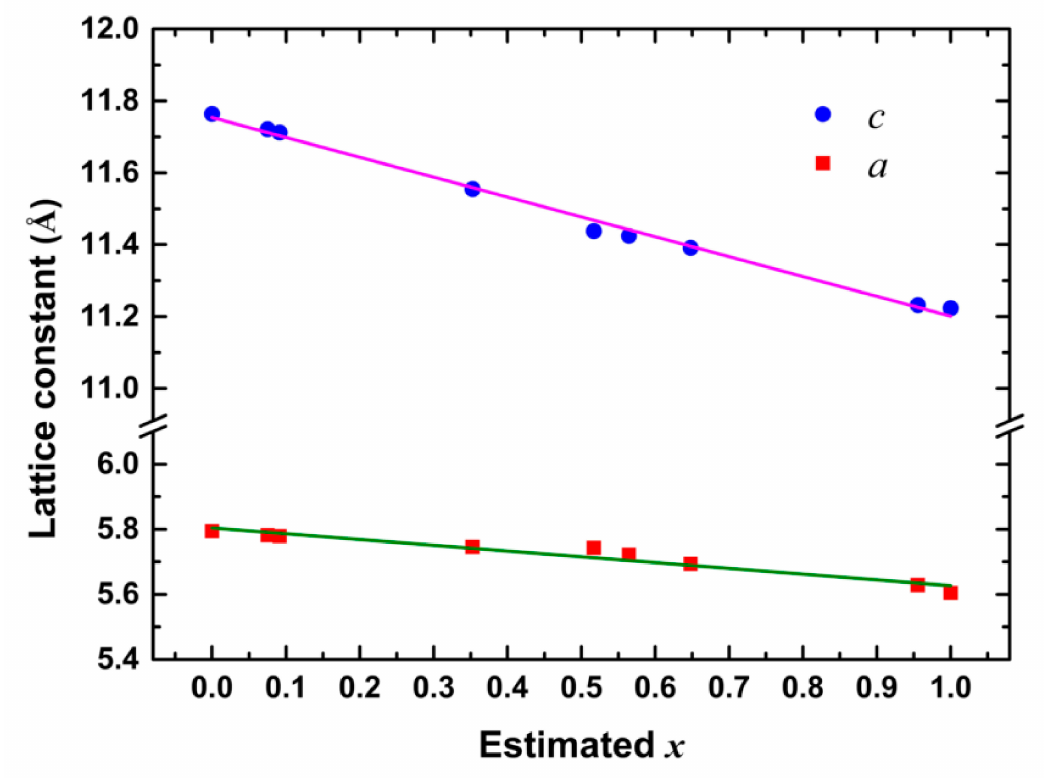
Figure 2. Lattice constants of CuIn 1 − x Ga x Se 2 nanocrystals as functions of estimated x